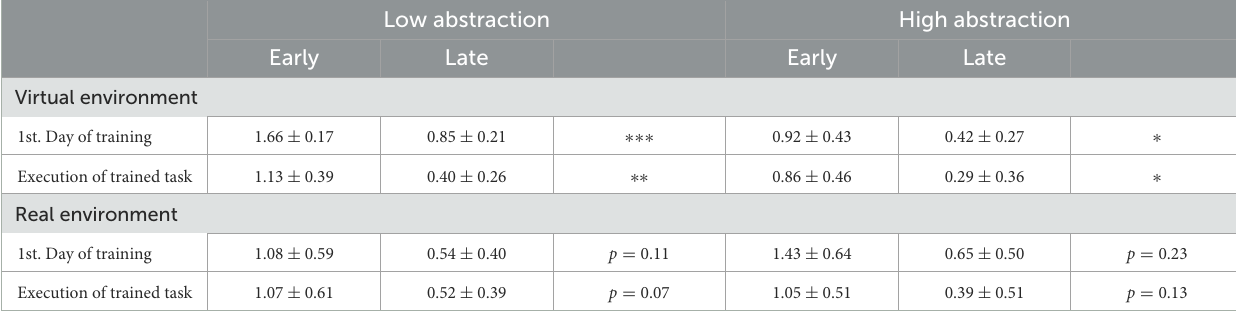
TABLE 3 Entropy of brain activity temporal segments in the motor task (a one-tailed Mann–Whitney U analysis was